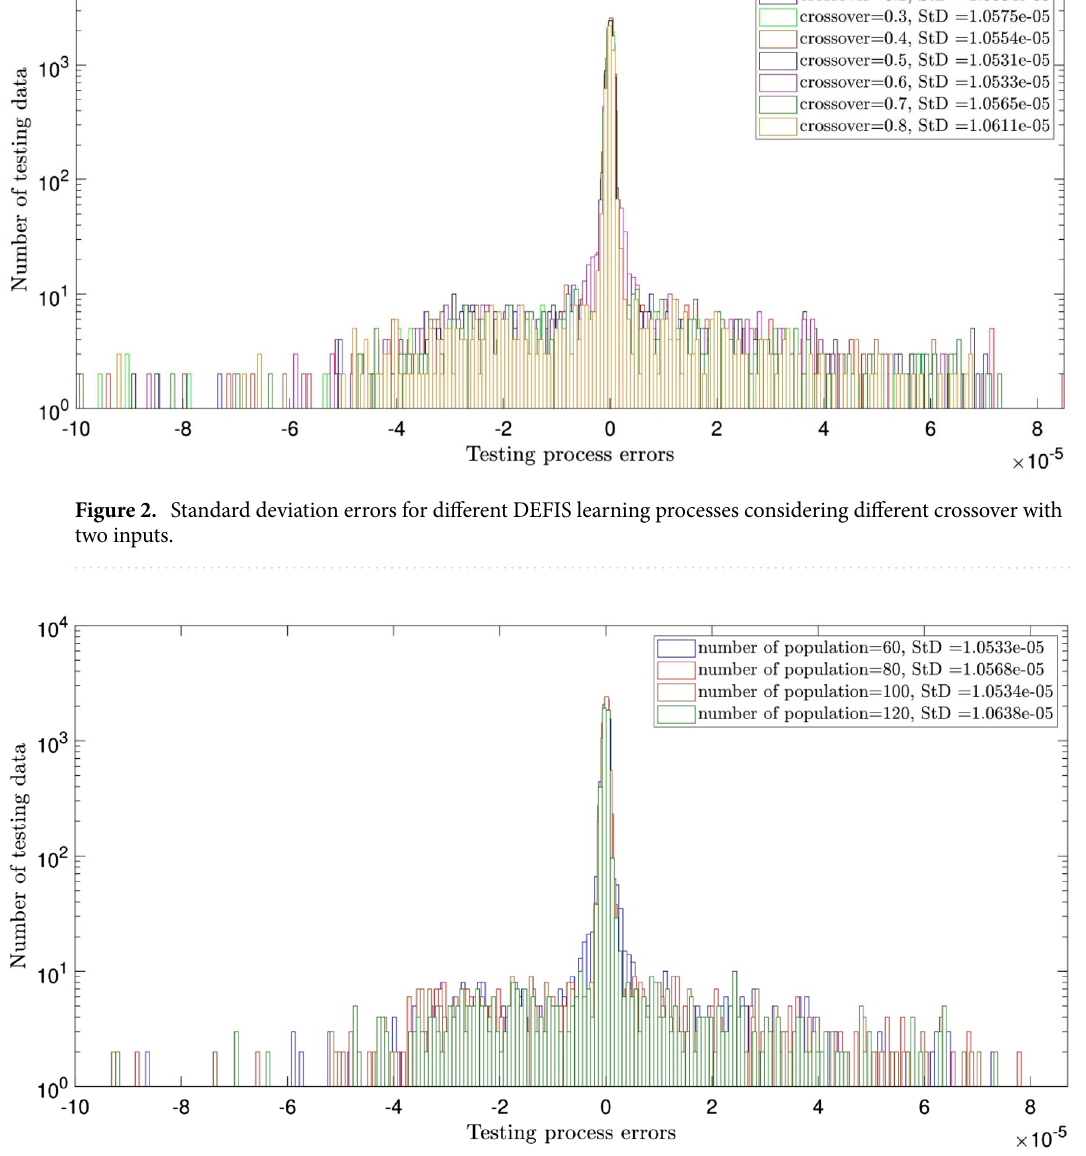
Figure 3. Standard deviation errors for different DEFIS learning processes considering different population with two